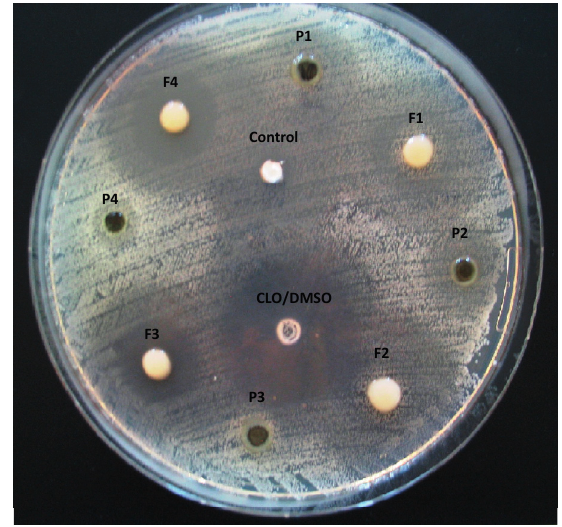
Figure 2. Representative image of plate diffusion test (after 24 h at 37 °C and 5% CO 2 ) for Candida albicans 1307562 demonstrating the zone of inhibition around the wells containing: placebo hydrogels (P1–P4), unmodified chitosan and chitosan/ β -GP hydrogels with clotrimazole (CLO) (F1–F4), control (commercially available cream with CLO) and reference standard